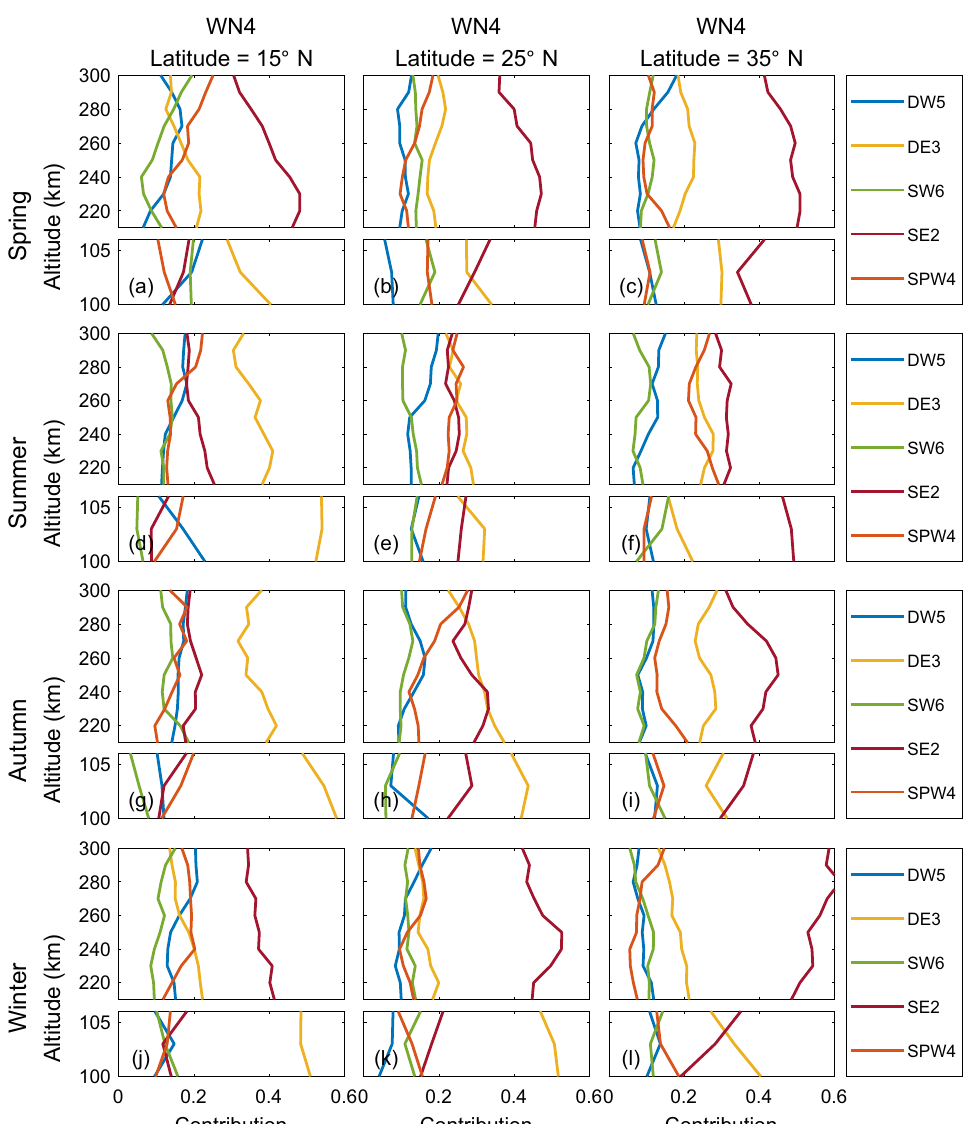
Fig. 7 Same as Fig. 4, but shows the contribution of potential sources to WN2, the blue, yellow, green, purple and orange line represent DW5, DE3, SW6, SE2 and SPW4,